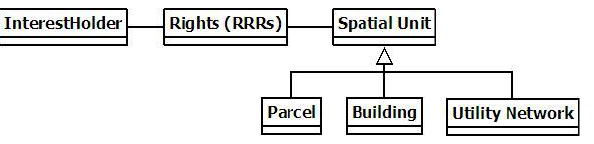
Figure 2. Spatial Package in current cadastral data models (ISO/DIS,